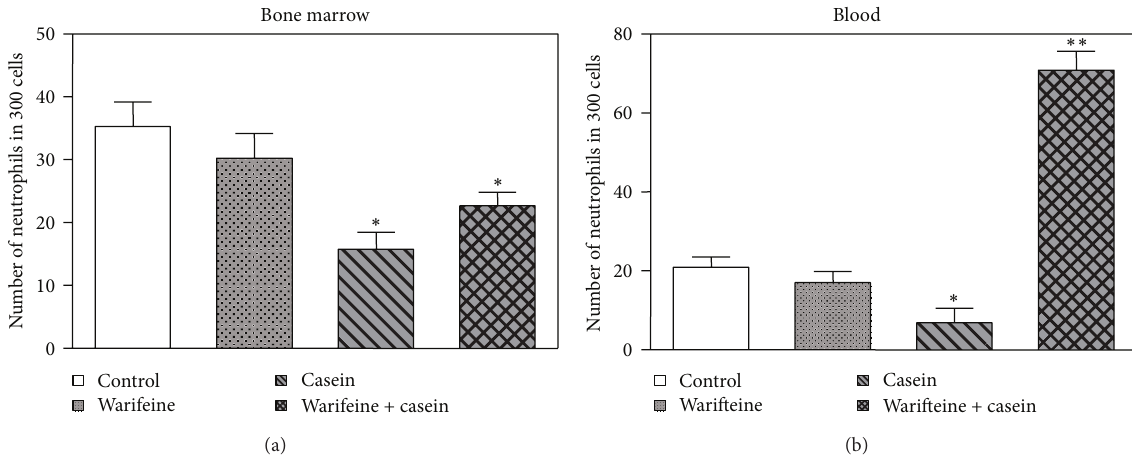
Figure 5: Number of polymorphonuclear leukocytes in the bone marrow and peripheral blood of mice treated with casein and warifteine. Mice were treated with warifteine, casein, or both substances. After a three-hour period past casein treatment, bone marrow (a) and blood samples (b) were obtained. Blood smears and bone marrow cytospins were analyzed by optical microscopy after staining. The graph shown in (a) indicates the mean value from data obtained in two experiments ( 𝑛 = 3 animals per group). ∗ 𝑃 ≤ 0.05 when comparing the group of animals treated with casein with untreated animals (controls). There was no statistical difference between the group treated with casein and the one treated with warifteine plus casein. Data shown in (b) indicate the percentage of blood neutrophils in different groups and are the mean value from three independent experiments ( 𝑛 = 3 animals per group/experiment). ∗ 𝑃 ≤ 0.05 when comparing animals treated with casein with the untreated ones and ∗∗ 𝑃 ≤ 0.05 in the comparison of the groups of animals treated with warifteine and casein with the group treated with casein only.